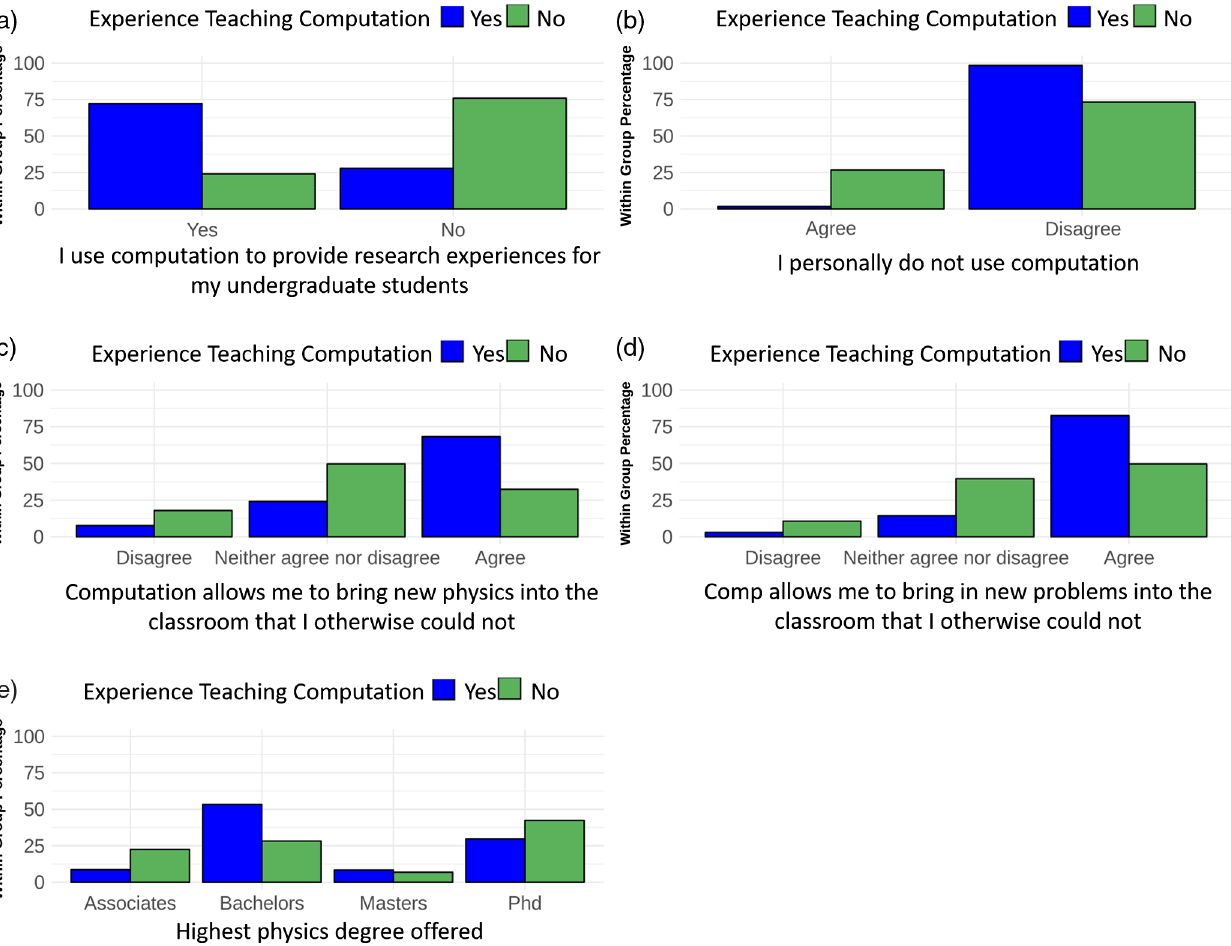
FIG. 3. Distribution of responses based on whether faculty do or do not have experience teaching computation. Here, within group percentage means the percentage of faculty within the group who use computation or the group who does not use computation. Since these five factors are the meaningful factors, we expect that the distribution of responses should be different between faculty with experience teaching computation and those who do not. Plot A shows the distribution of the most important feature while plot E shows the fifth most important feature. All five plots have χ 2 with corrected p < 0 . 05 .